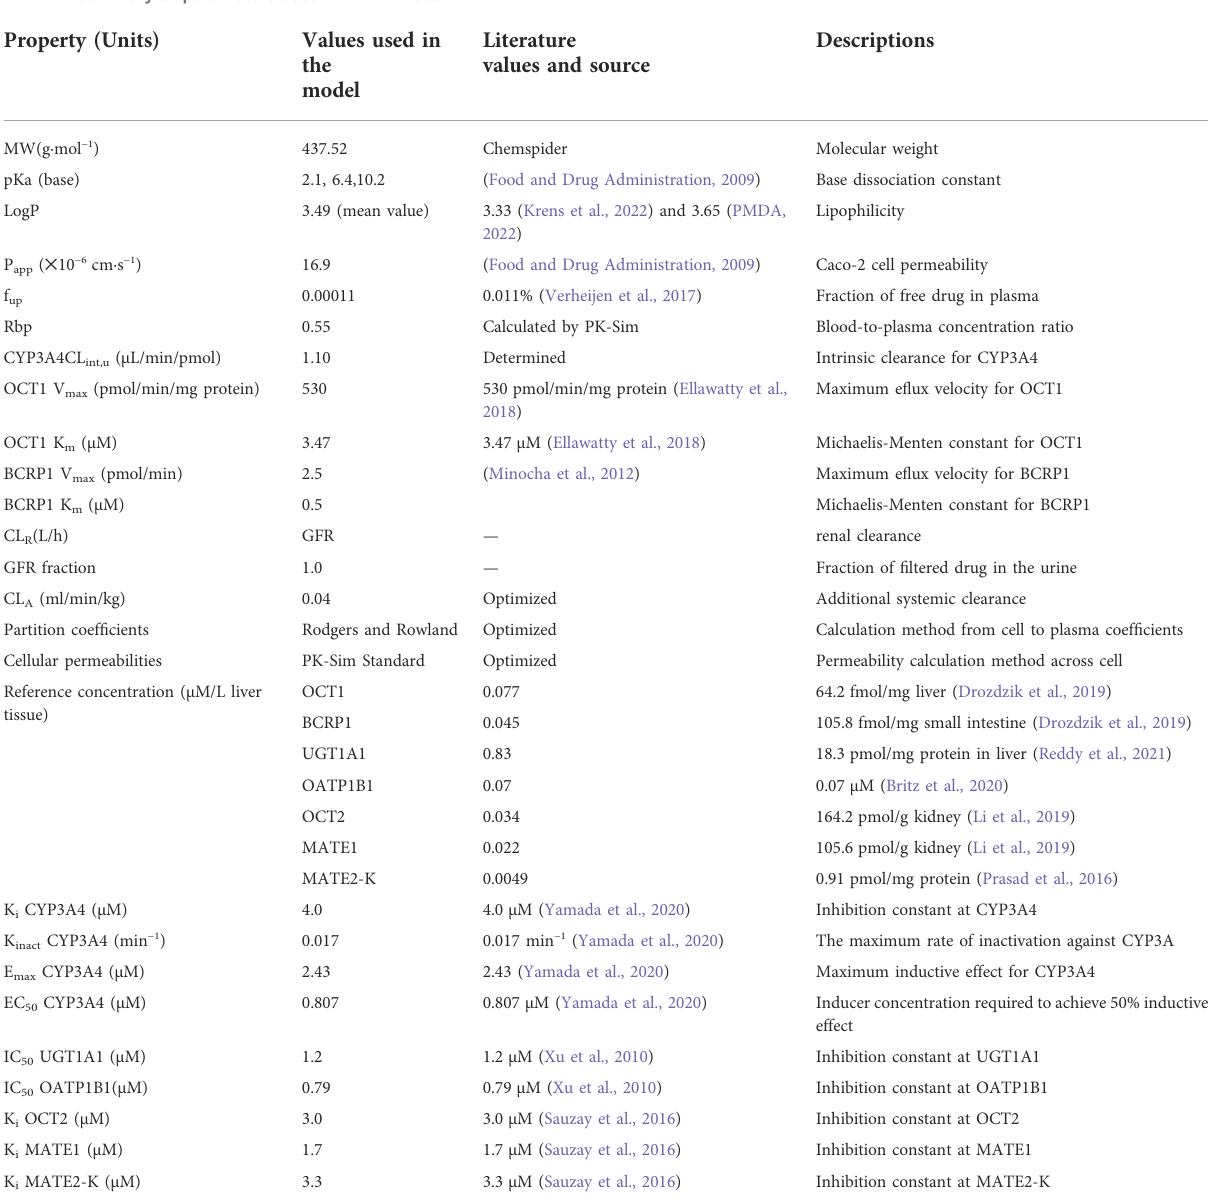
TABLE 2 Summary of parameters used in PBPK